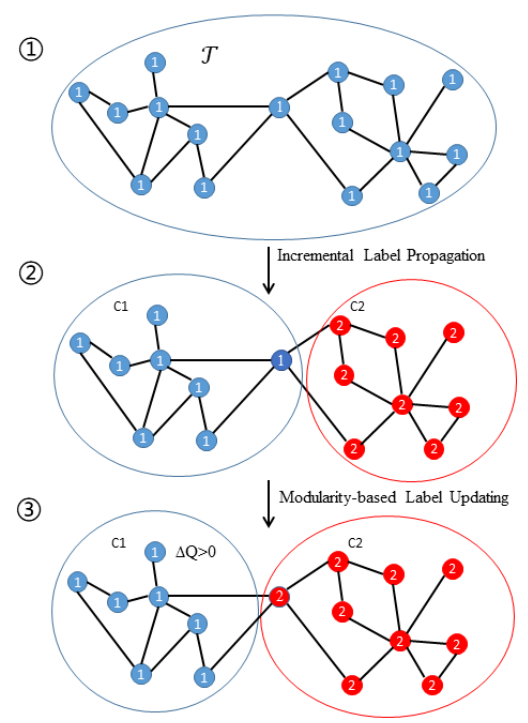
Figure 1. The process of MILPA. Steps 1 – 2 show the process of incremental label propagation and steps 2 – 3 show the process of modularity-based label updating.